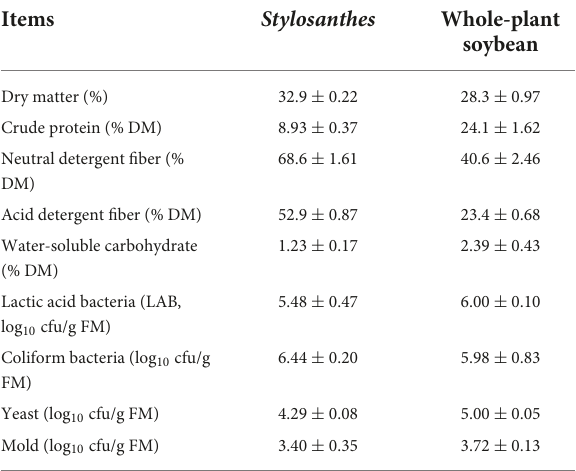
TABLE 1 The chemical compositions and microbial population of stylo and whole-plant soybean (WPS) before ensiling (Mean ± SD, n =